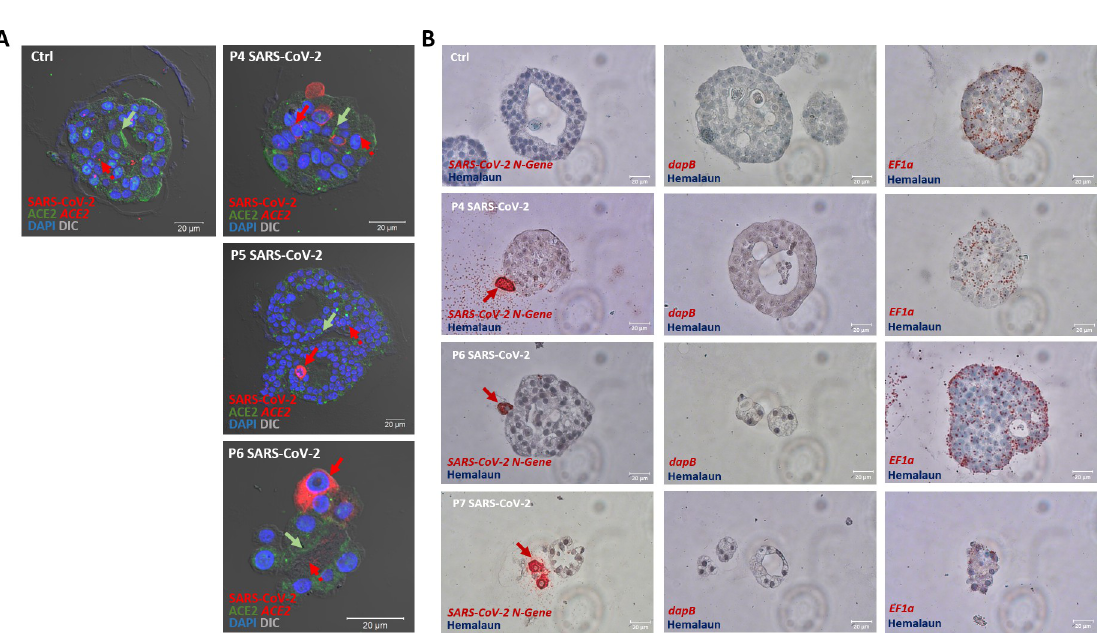
Fig 5. Spectral imaging of mock- and SARS-CoV-2-infected and immunostained human alveolar-like organoids and in situ hybridization. (A) Representative immunostainings for exemplary mock- (left panel) and SARS-CoV-2-infected (right column) human alveolar-like organoids. Shown are immunostainings for SARS-CoV-2 (N-protein, red), ACE2 (green) and via in situ hybridization visualized ACE2 mRNA expression (red dots) 24 h post infection (MOI = 1). Arrows indicate either cells positive for SARS-CoV-2 (red arrows) or areas of particularly high ACE2 expression (protein: green arrows, mRNA: red dotted arrows). Cell nuclei are visualized by DAPI stain (blue). Scale bars = 20 μ m. (B) In situ hybridization of human alveolar-like organoids shows SARS-CoV-2 mRNA expression (left column). DapB and EF1a served as negative respectively positive control. Red arrows indicate cells positive for SARS-CoV-2. Scale bars = 20 μ